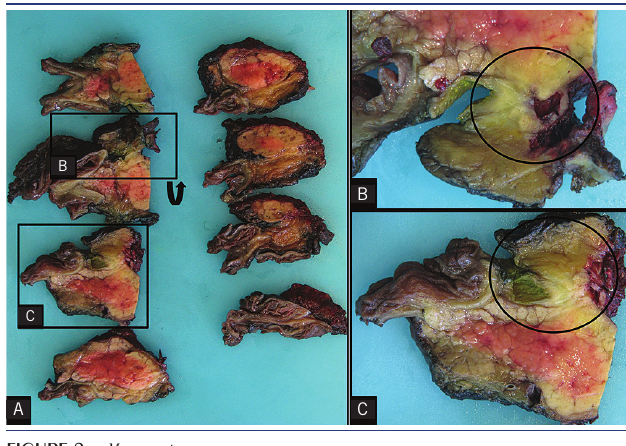
figurE 2 − Macroscopy A) pancreatic sections, perpendicular to the bile duct (from superior to inferior); B) contralateral view of the section, showing a yellow-white lesion, coincident with the uncus surgical margin; C) following section, presenting the continuity of the same lesion, involving the bile duct, touching the uncus surgical